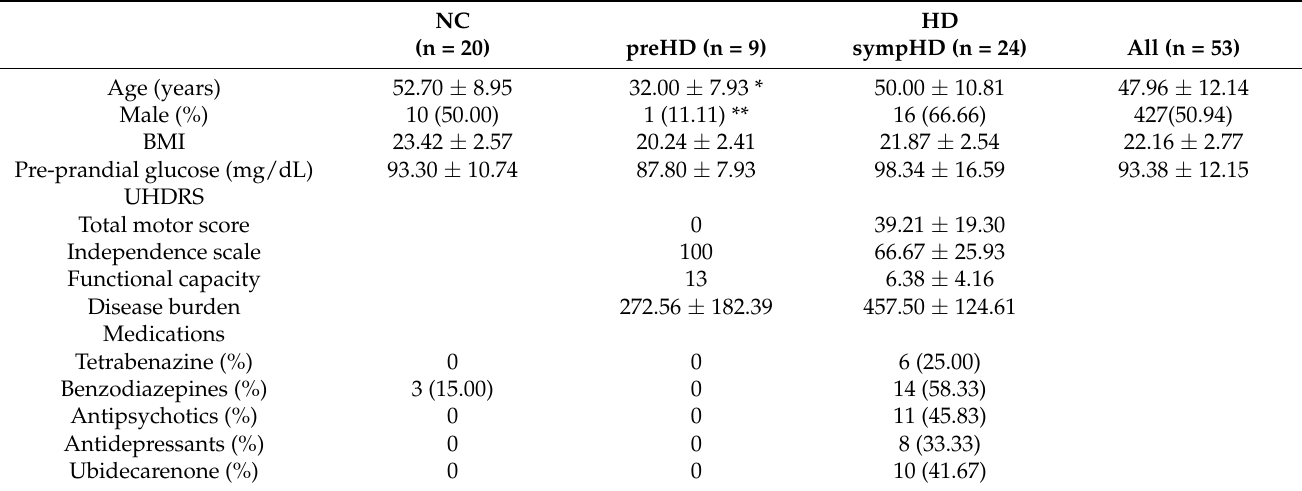
Table 1. Demographic characteristics and blood biochemical parameters of included the patients with Huntington’s disease (HD) and the normal controls (NC).